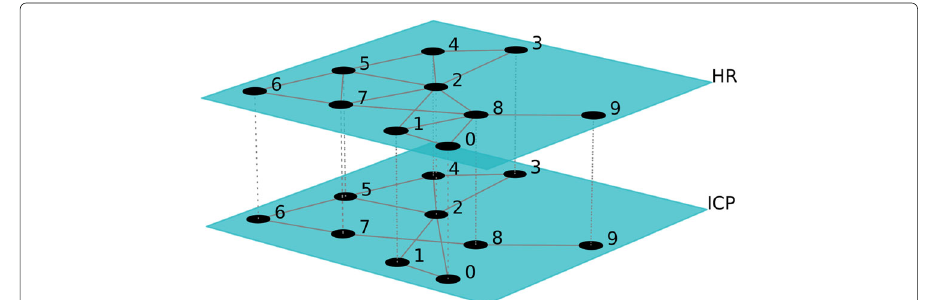
Fig. 6 Visualization of the multiplex visibility graph for the ICP and HR with a cross talk event: Multiplex Visibility graph of ICP and HR in the time window with a cross talk event detected (Mikko